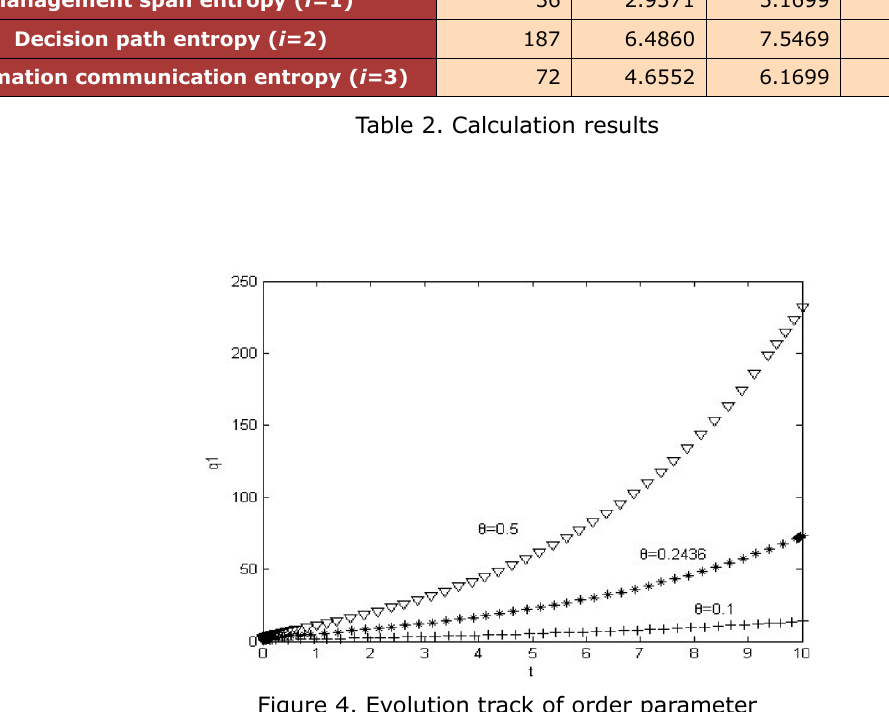
Figure 4. Evolution track of order